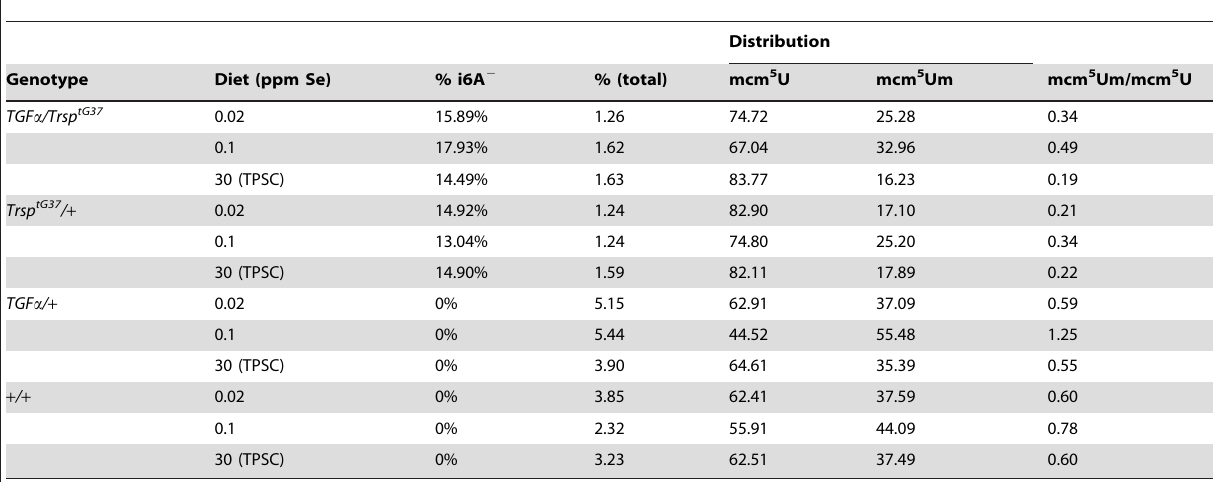
Table 6. Levels and distributions of the Sec tRNA [Ser]Sec isoforms in liver of mice a .